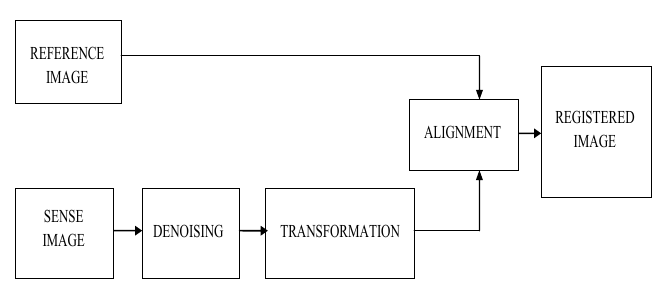
Fig 1 . Block Diagram of Proposed Image Registration